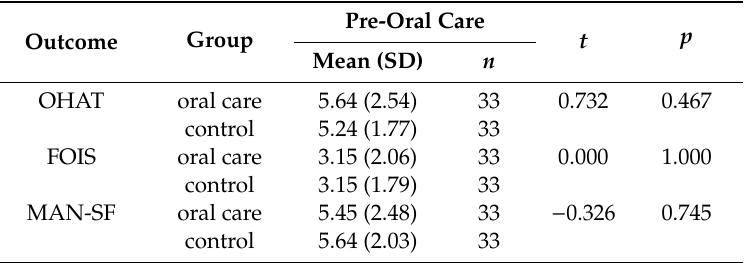
Table 2. Baseline Oral Health Assessment Tool (OHAT), Functional Oral Intake Scale (FOIS), and Mini-Nutritional Assessment-Short Form (MNA-SF) scores between the oral care and control groups. Pre-Oral Care Outcome Group